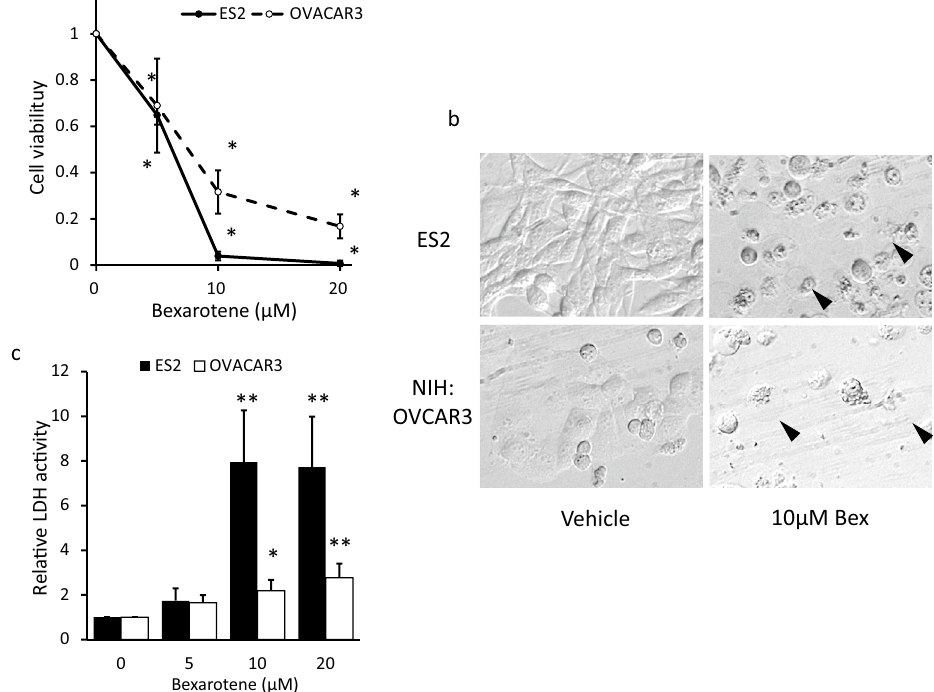
Figure 1. Bexarotene treatment reduced cell viability and induced cell death by LDH release and plasma membrane bursting. ( a ) In ES2 and NIH:OVACAR3 cells, counted manually were cell numbers after 24 h of bexarotene treatment. Measured was the cell viability against the bexarotene nontreated group. The results presented were the mean, ± standard deviation for at least three independent experiments. ( b ) Morphological analysis of ES2 cells (upper two panels) and NIH:OVACAR3 (lower two panels). The plasma membrane expanded, and the broken cells had a swollen structure (arrow). ( c ) bexarotene treatment was extracellular LDH activity. The results presented were the mean ± standard deviation for at least three independent experiments. * p < 0.05, ** p < 0.01, compared with bexarotene-free control. LDH, lactate